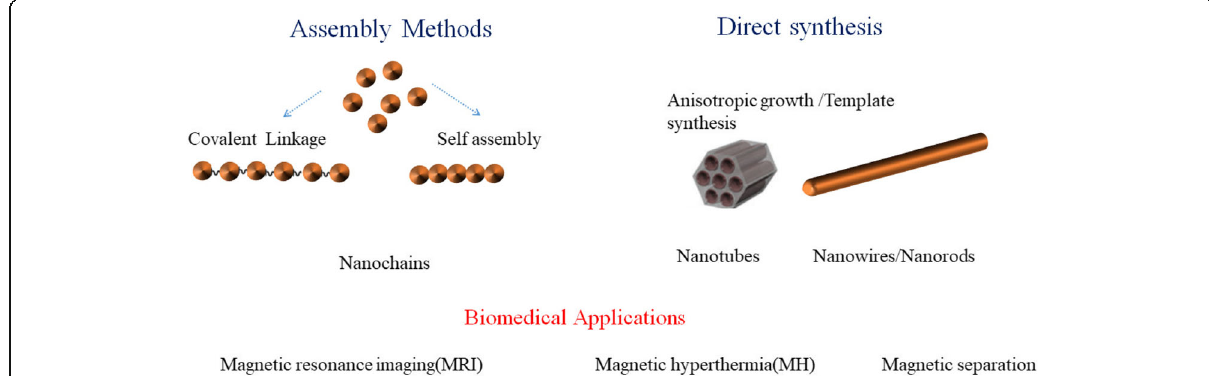
Fig. 1 Highly shape anisotropic magnetic nanowires prepared through direct synthesis or assembly methods and their biomedical